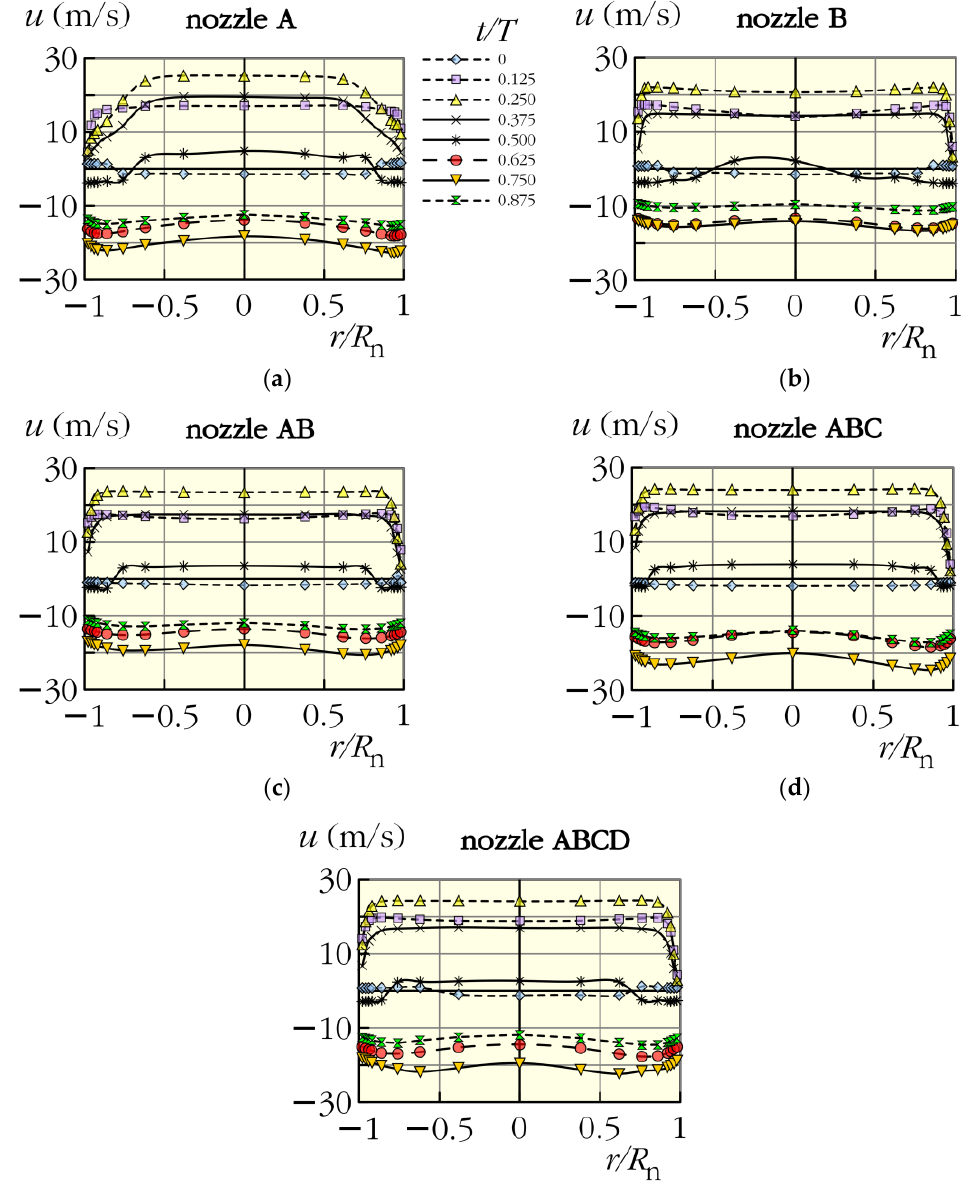
Figure 4. Velocity profiles measured by the hot-wire probe at the nozzle exits at input power of 0.68 W and the optimal (resonant) frequencies quantified in Figure 2.